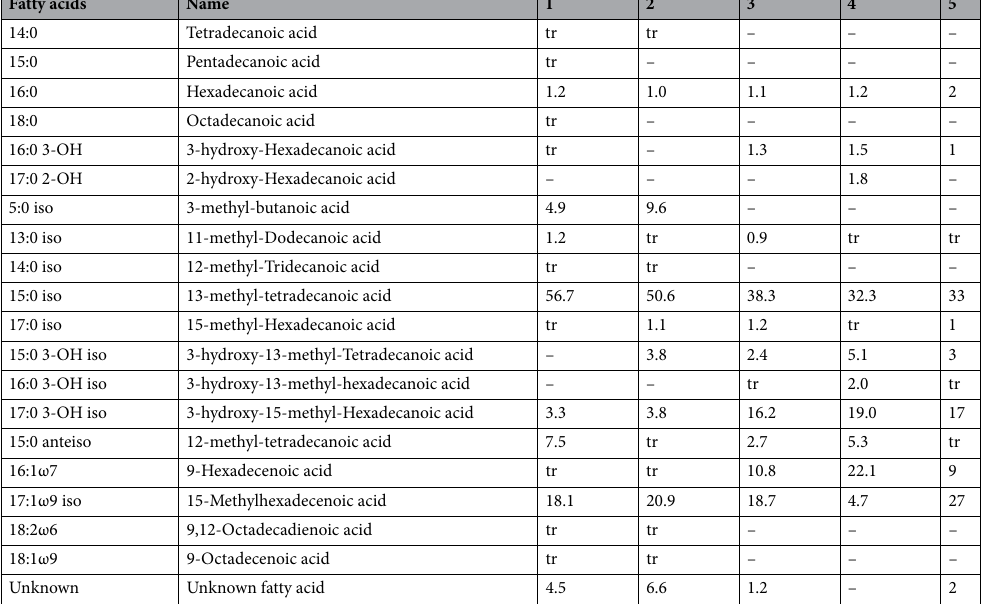
Table 7. Cellular fatty acid composition of Marseille-P9602 strain compared with related species. Taxa: 1, Marseille-P9602; 2, C. scophthalmum ; 3, C. piscium ; 4, C. indoltheticum ; 5, C. balustinum . The results presented for 1 and 2 were obtained in the present study. The results presented for 3, 4 and 5 were completed using previously published studies 54,55 . Analysis of the fatty acid methyl esters was performed by Gas liquid chromatography according to the instructions for the Microbial Identification System (MIDI). tr, Trace (< 1%); not detected (−); present (+); NA, data not